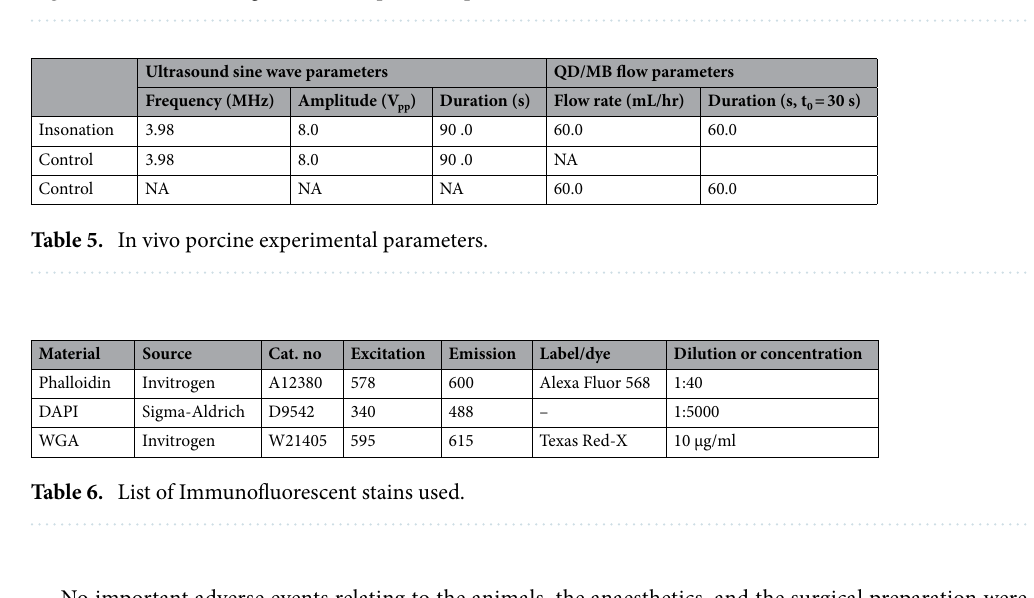
Figure 6. Schematic diagram of the capsule setup for the in vivo trial.